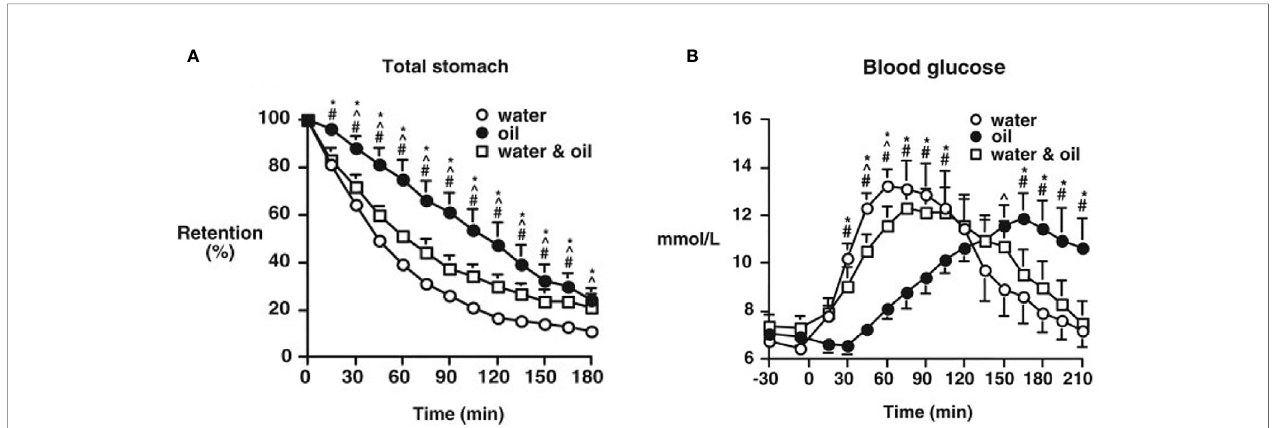
FIGURE 2 | Gastric emptying (A) and blood glucose concentrations (B) , after ingestion of a mashed potato meal when either 30 ml olive oil (oil), 30 ml water (water), or 30 ml water with 30 ml olive oil (water and oil) was consumed 30 minutes before the meal by type 2 patients. Data are the mean ± SEM. *P < 0.05, oil vs. water; # P < 0.05, oil vs. water and oil; ^P < 0.05, water vs. water and oil. [Reprinted with permission from Gentilcore et al.